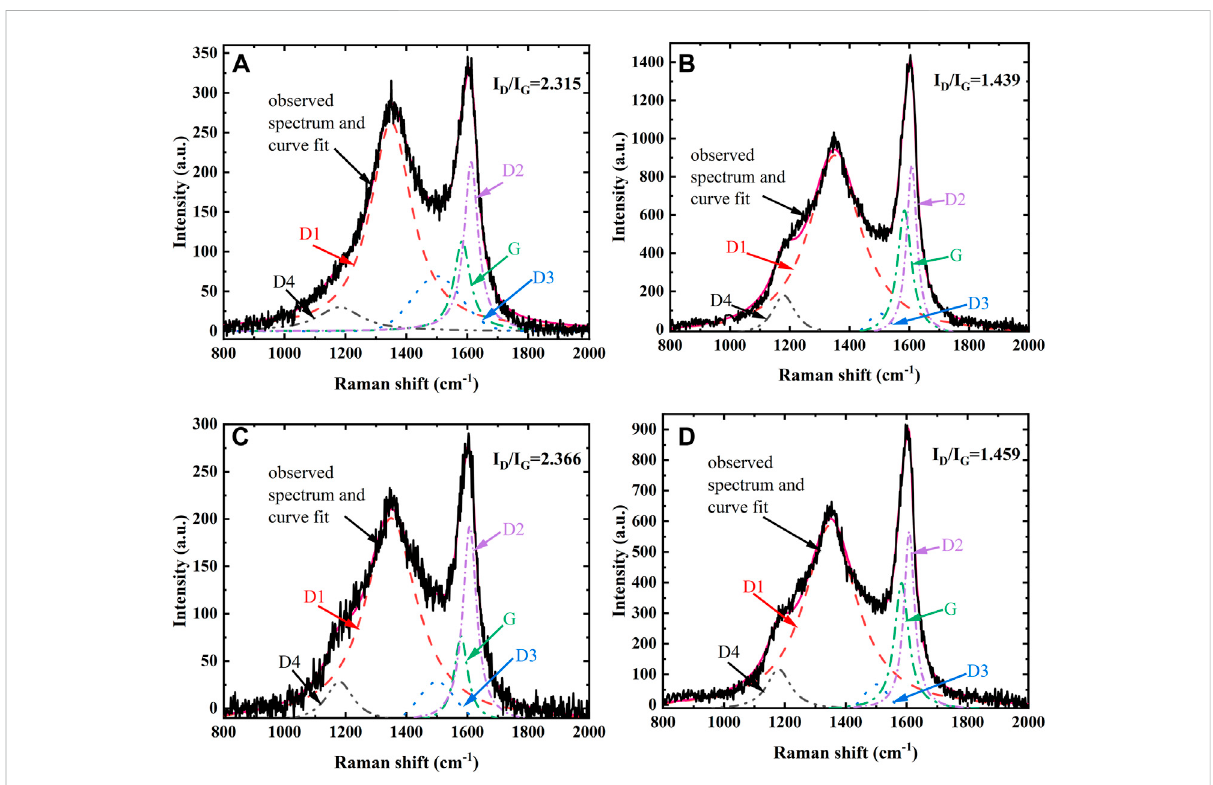
FIGURE 1 First-order Raman spectra and split-peak fi tting curves of soot from different conditions, (A) 1323 K, (B) 1423 K of pure ethylene pyrolysis, (C) 1323 K, (D) 1423 K ethylene-doped ammonia pyrolysis.